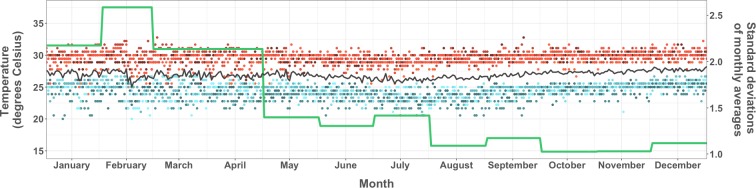
Daily temperature highs and lows, daily average temperature for the 5-year interval, and standard deviation of daily averages by month, Fortaleza, 2011–2015.Values of daily high, low, and average daily temperatures were obtained from each year. High values are represented by dots colored in shades of red, and low values by dots colored in shades of blue. The black line summarizes the daily average for the 5-year period, and the green line shows the standard deviation of daily averages by month.